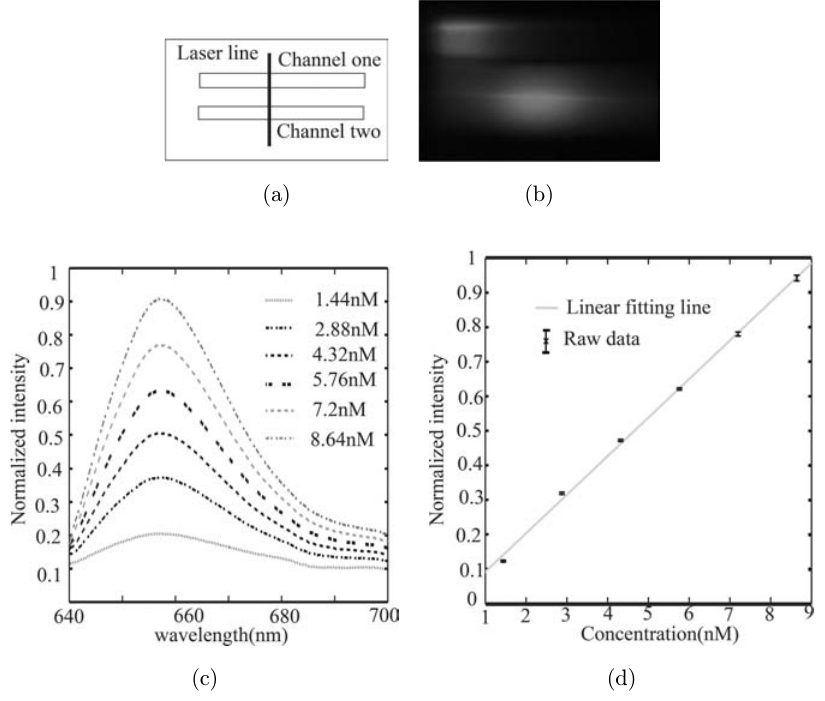
Fig. 5. Hyperspectral °uorescence analysis excited by CPWR. (a) Illustration of the °uorescence excitation model. (b) Raw spectrally resolved image captured by CCD, corresponding to the irradiated line region, the horizontal direction refers to distri- butions of °uorescence spectra while the vertical direction represents the vertical positions of the °ow channels. (c) Fluorescence spectra of Cy5 solutions with di®erent concentrations. (d) Relationship between concentrations and °uorescence intensities acquired by integrating °uorescence spectra at a wavelength range from 650 to 677 nm. (e) Hyperspectral detection and multivariate analysis of the solution mixed with Cy5 and Dylight680. Error bar shows the standard deviation of ¯ve